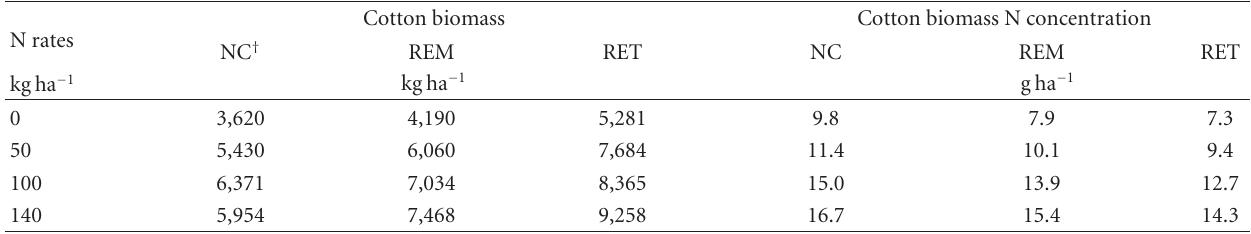
Table 3: E ff ects of rye residue management and N fertilization on cotton biomass production and cotton biomass N concentration between first square and cutout, averaged across years.